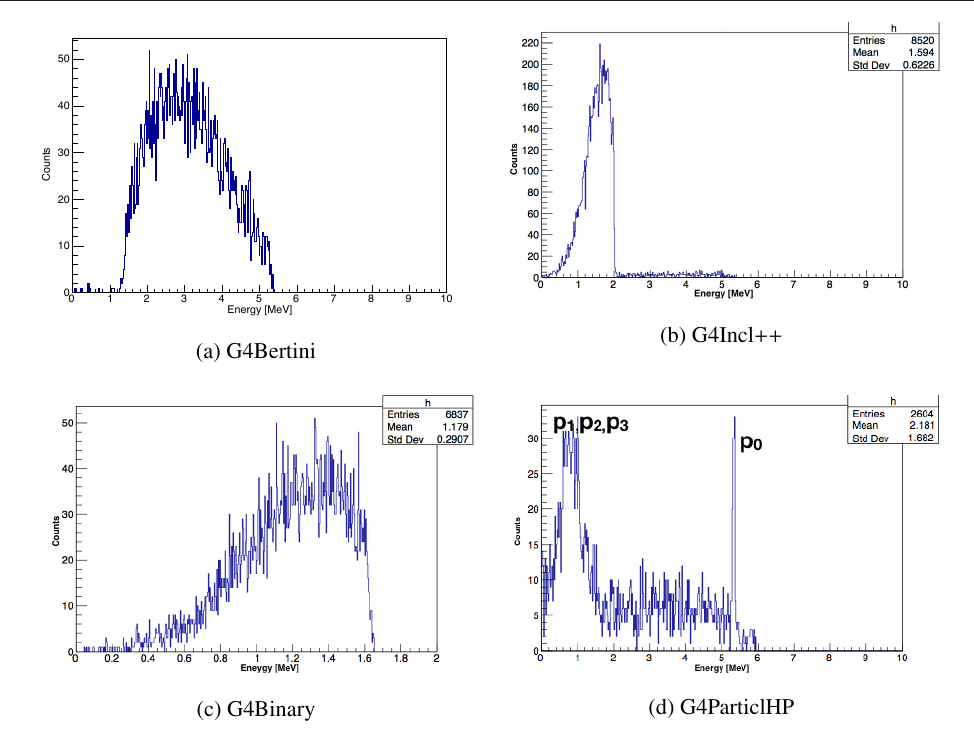
Figure 1: Proton yield from 10 B ( α, p ) 13 C reaction simulated by some built-in Geant4 models